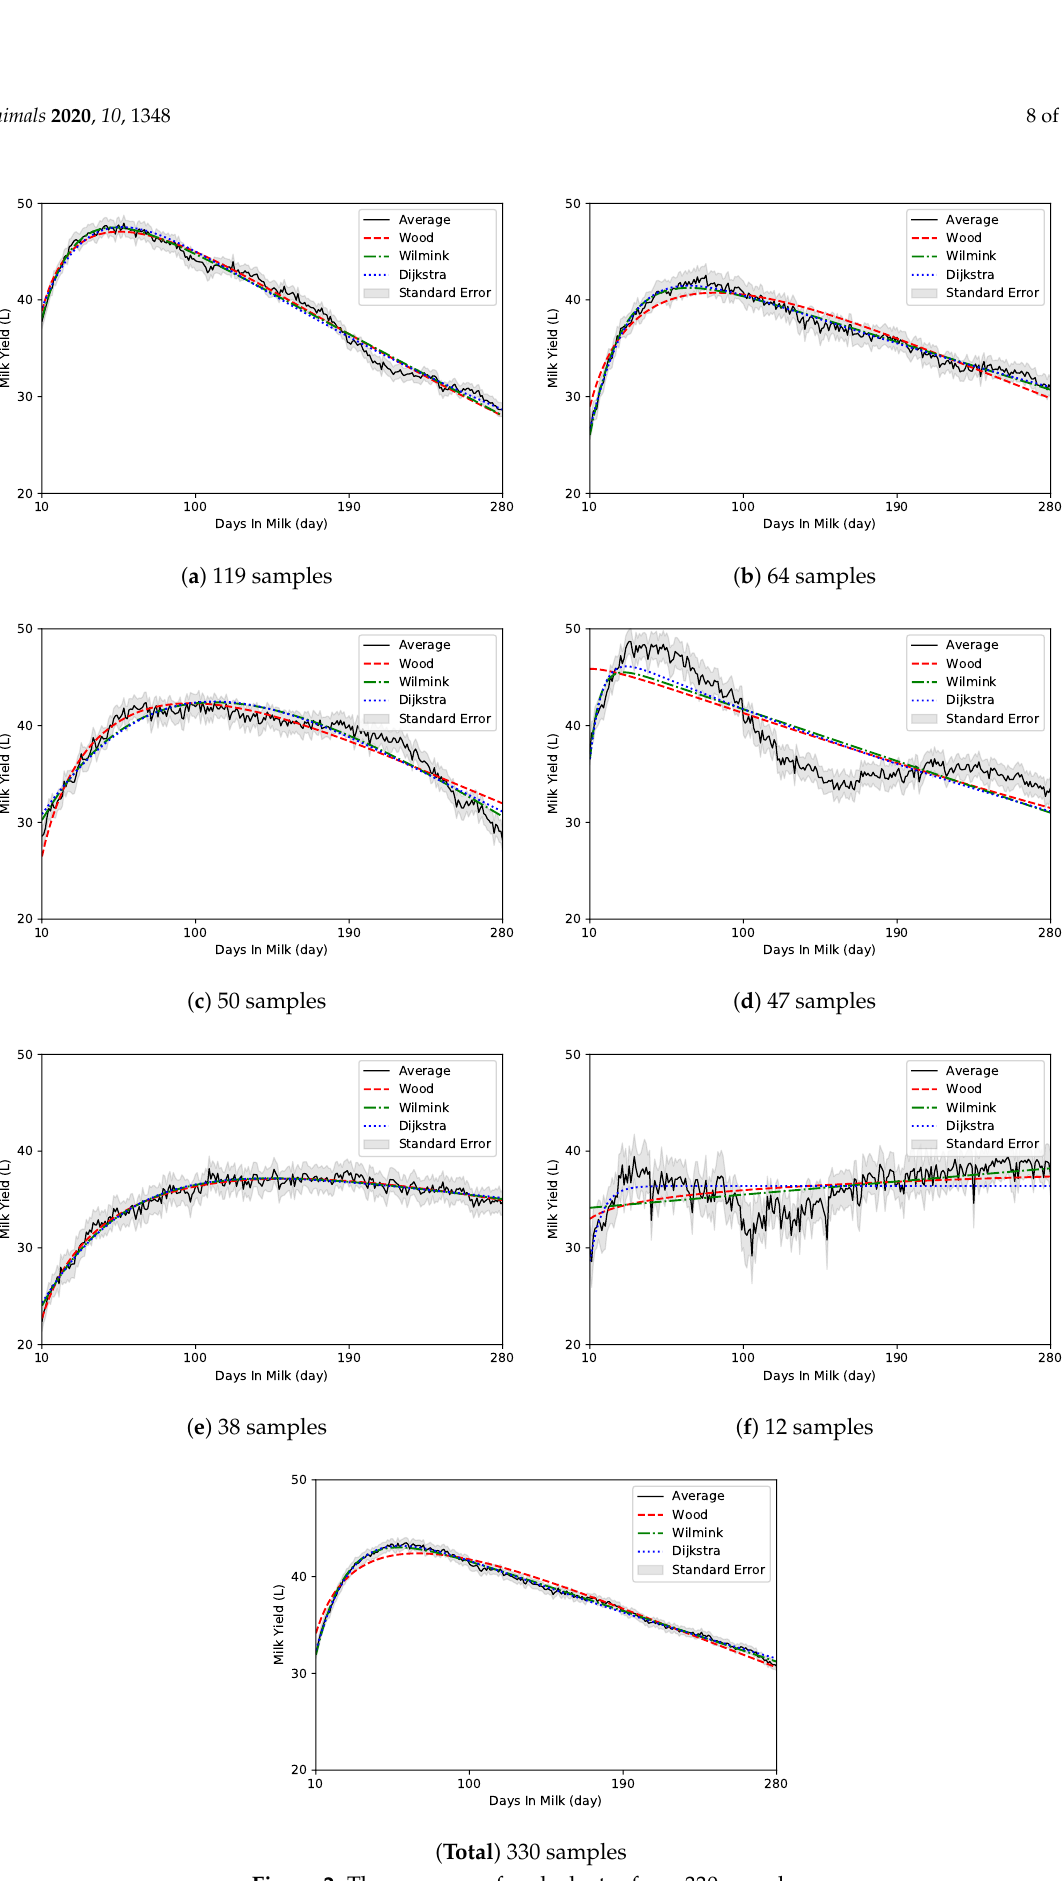
Figure 2. The averages of each cluster from 330